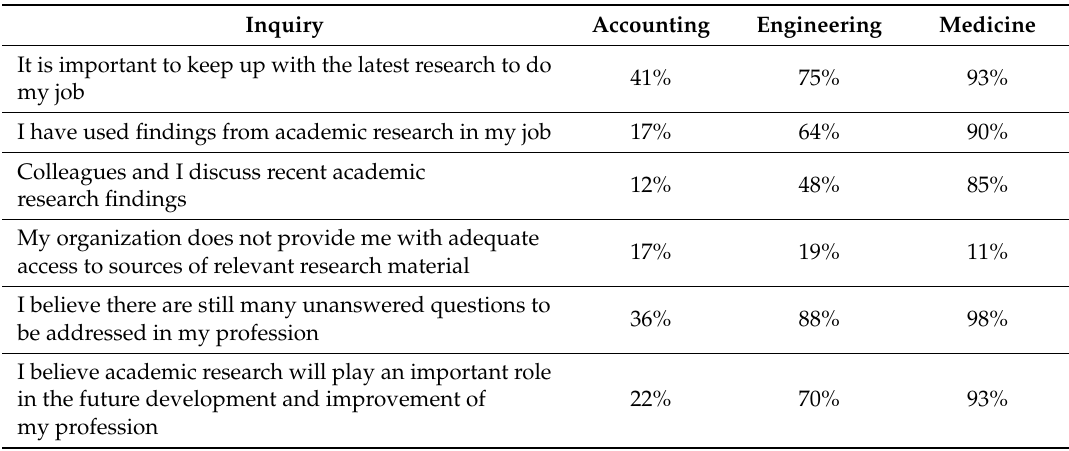
Table 7. Practitioners current and future need for academic